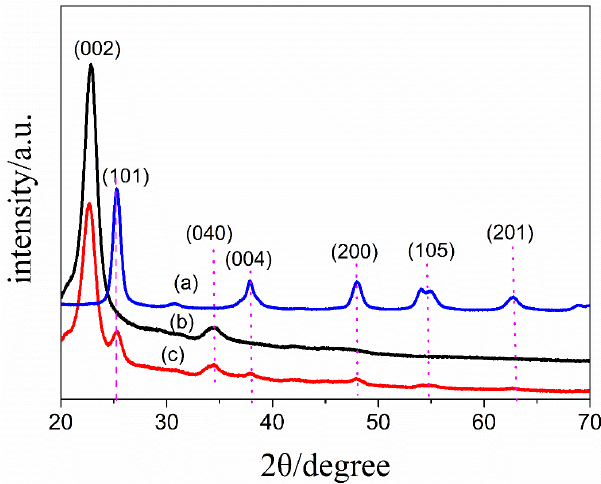
Figure 5. XRD patterns of ( a ) anatase TiO 2 , ( b ) cotton fabric and ( c ) TiO 2 NPs-coated cotton fabric.